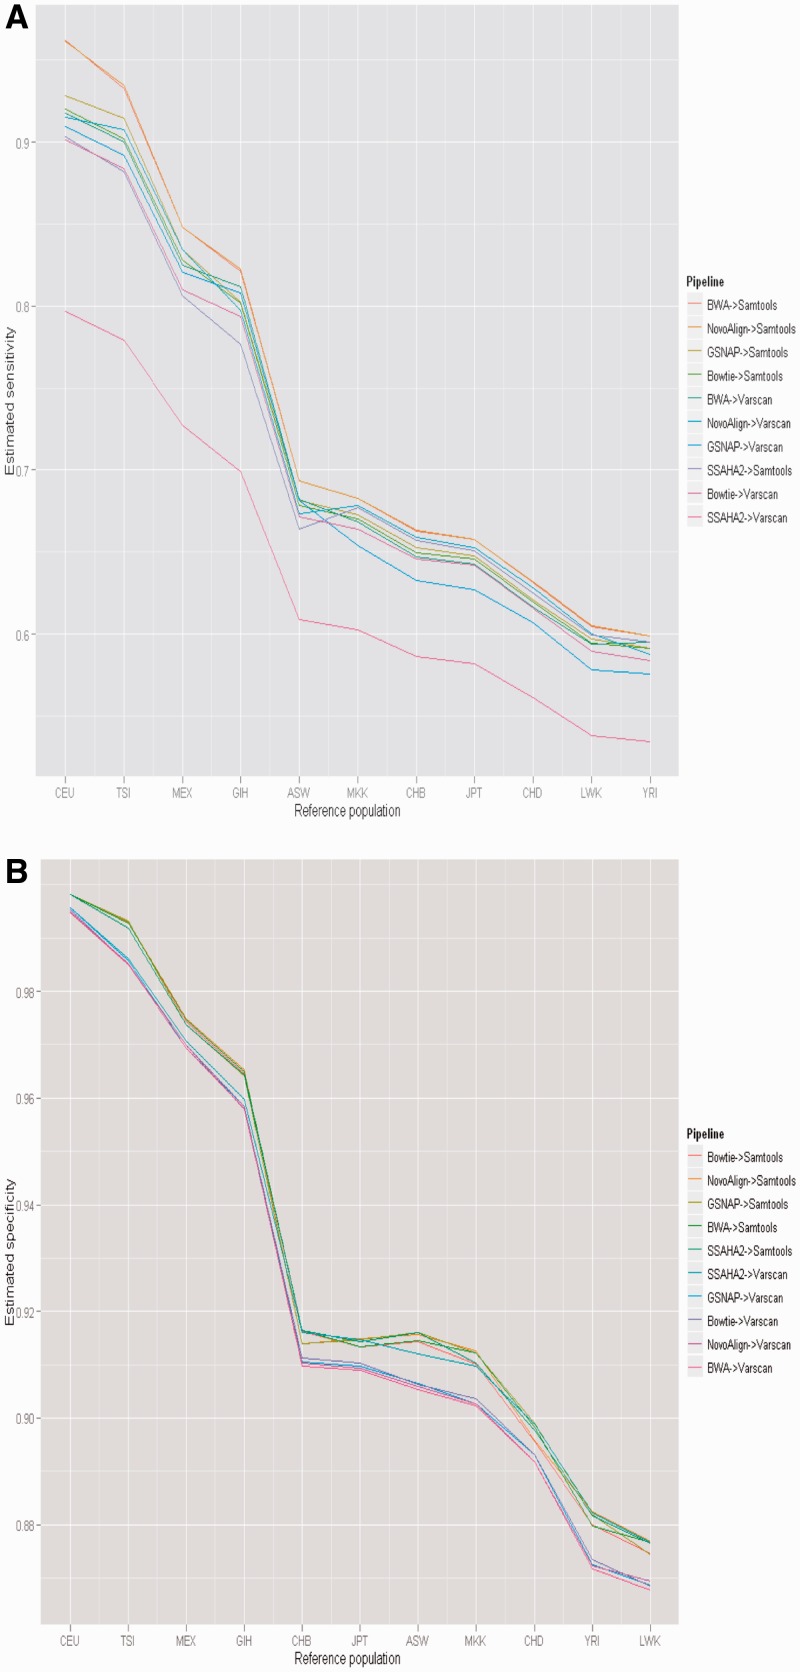
Effect of reference population misspecification. Values represent the average sensitivity across all individuals in our study. CEU: Utah residents with northern and western European ancestry from the CEPH collection; TSI: Tuscan in Italy; MEX: Mexican ancestry in Los Angeles, California; GIH: Gujarati Indians in Houston, Texas; ASW: African ancestry in southwest USA; MKK: Maasai in Kinyawa, Kenya; CHB: Han Chinese in Beijing, China; JPT: Japanese in Tokyo, Japan; CHD: Chinese in Metropolitan Denver, Colorado; LWK: Luhya in Webuye, Kenya; YRI: Yoruban in Ibadan, Nigeria